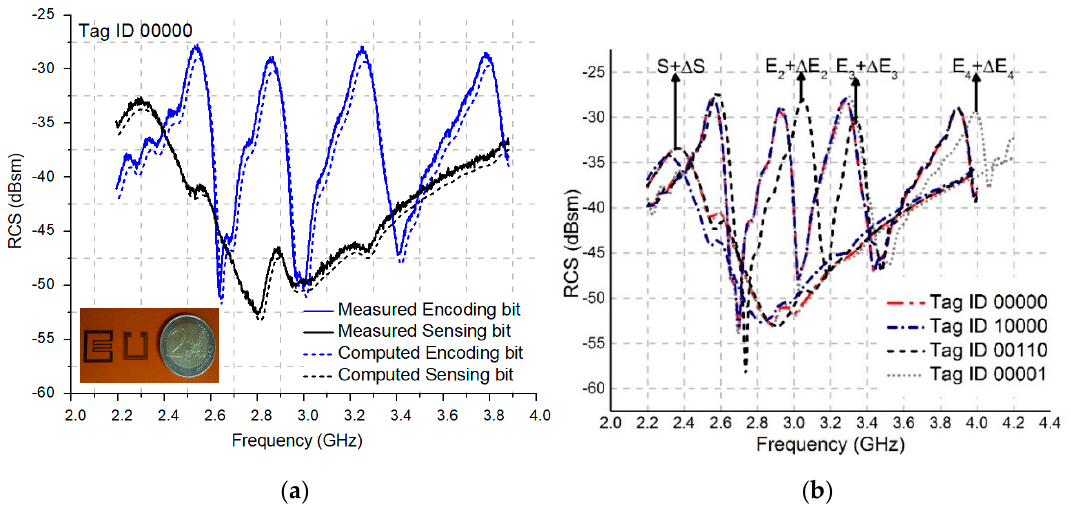
Figure 5. ( a ) Measured and computed RCS response, ( b ) measured tag